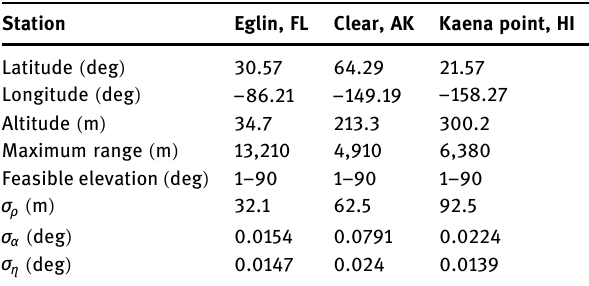
Table 2: Parameters of three radar stations